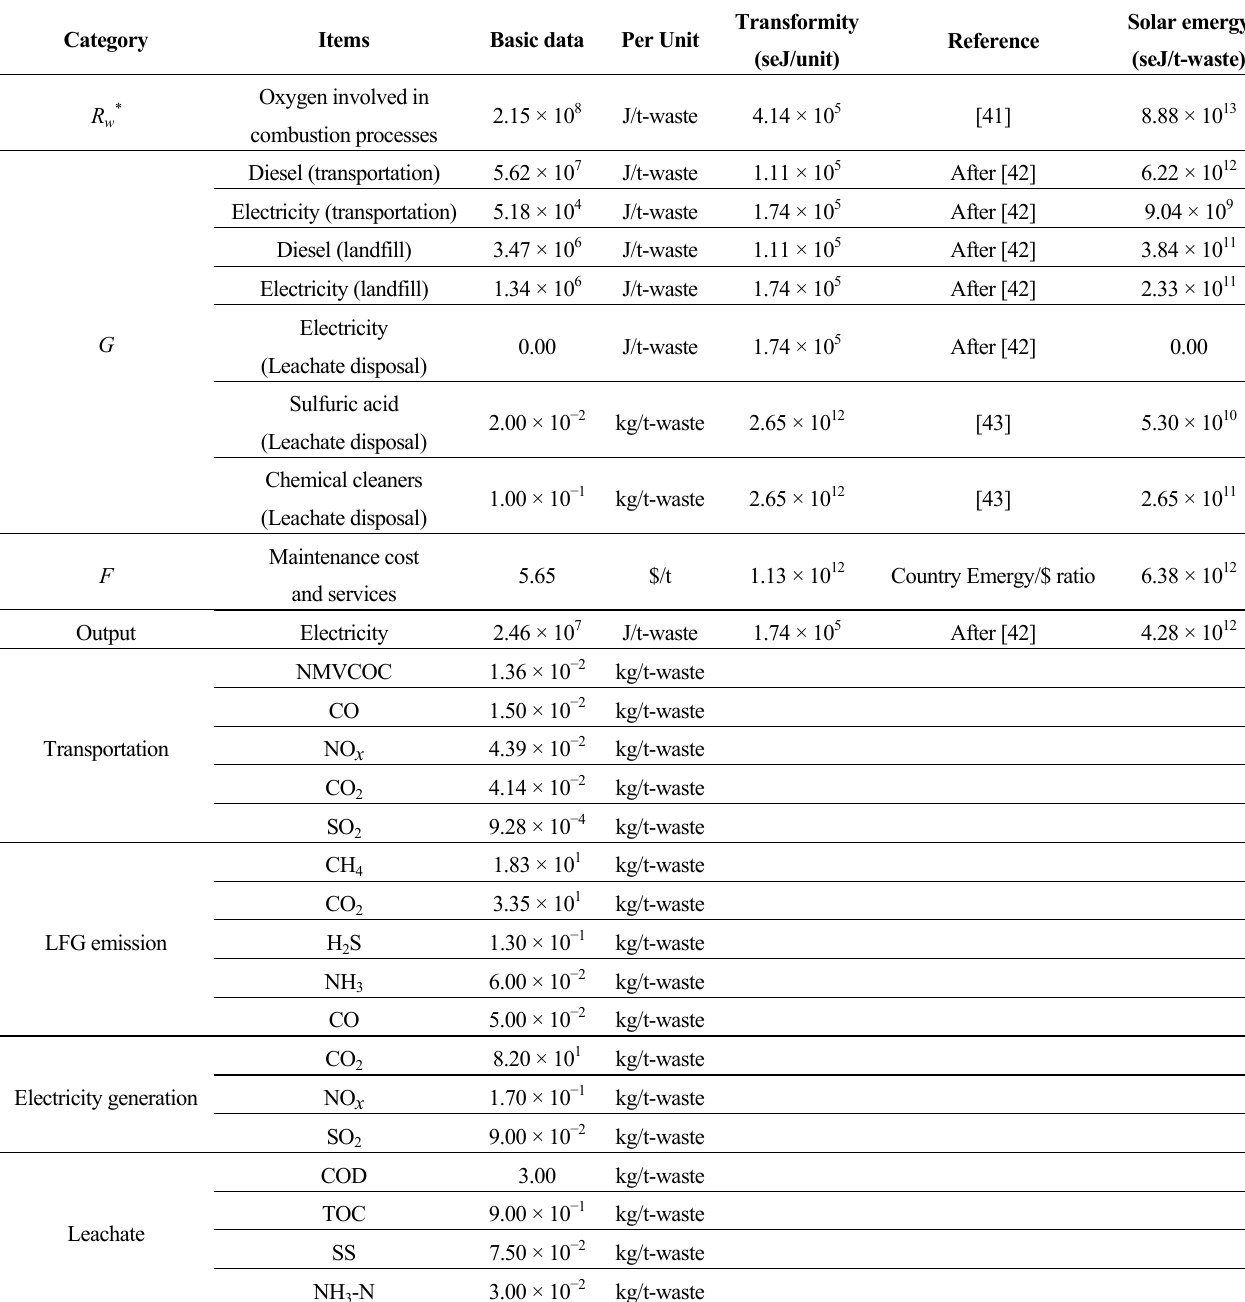
Table 2. The emergy analysis table of sanitary